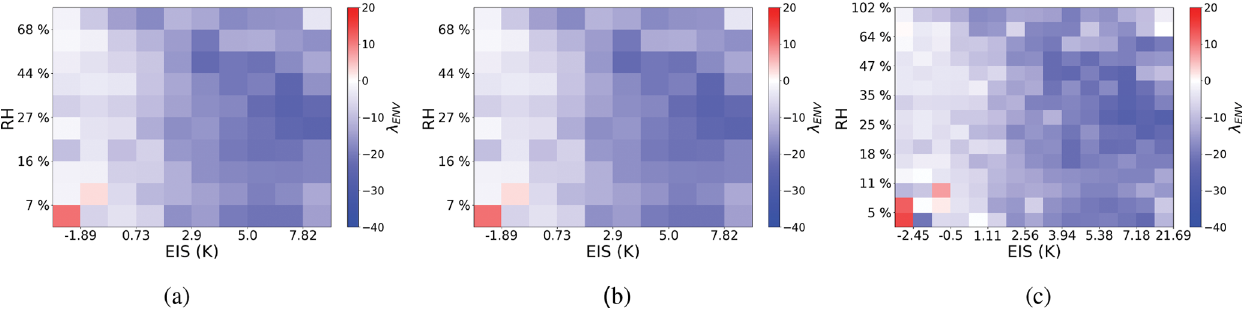
Figure 4. The sensitivity of the warm cloud CRE to aerosol ( λ ENV ) found using Eq. (7) for environmental frameworks of (a) 25